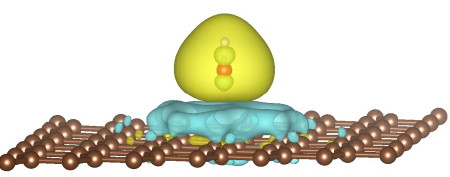
Figure 11. Difference in the charge distribution of graphene absorbing the hydroxide radical marked by red and white.